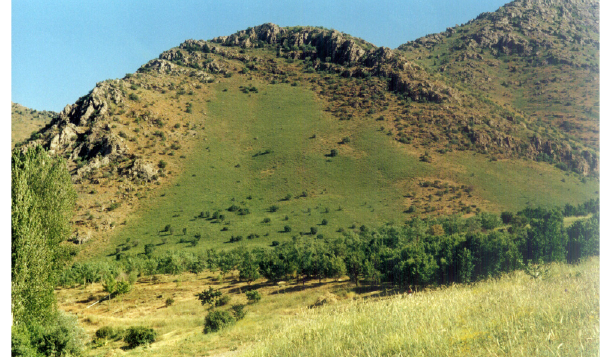
Fig. 3. Slopes steepness map of study area